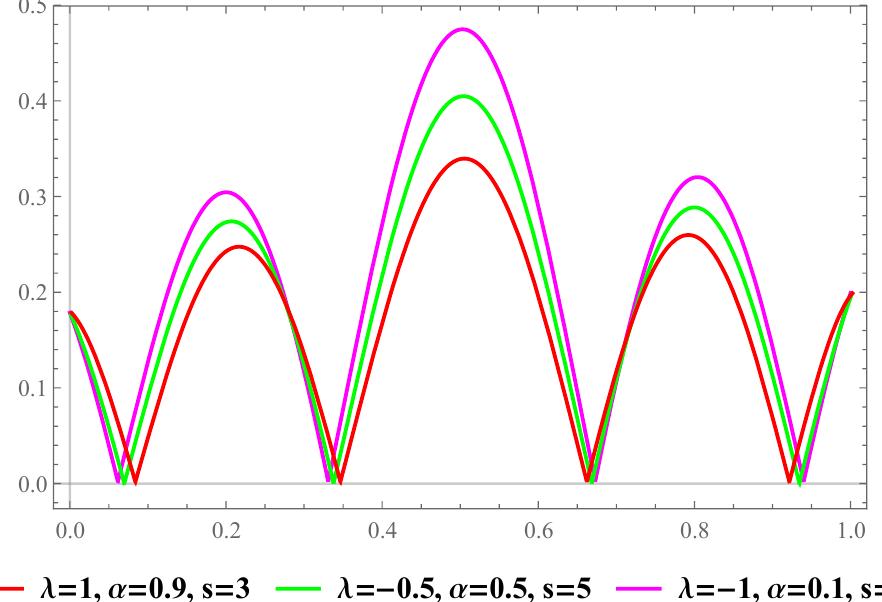
Figure 6. Maximum error of approximation for function r 3 ( u )